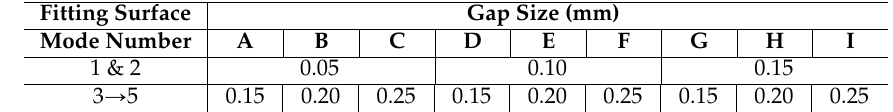
Table 7. Gap size matching modes.